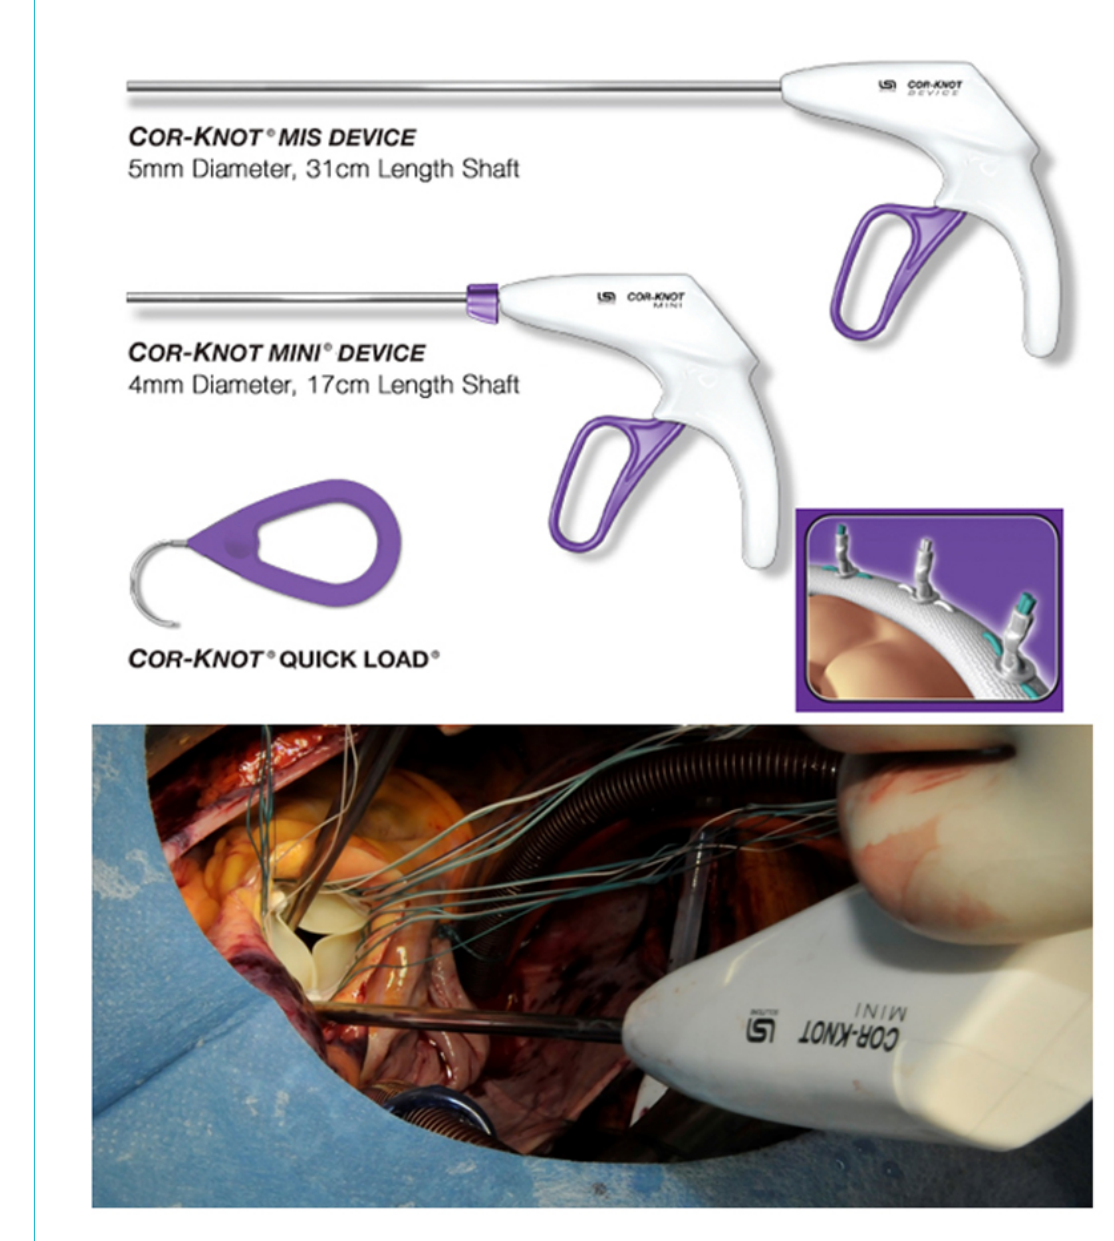
Figure 2: Intraoperative application of the Cor-Knot Device for aortic valve fixation (images courtesy of LSI SOLUTIONS ®